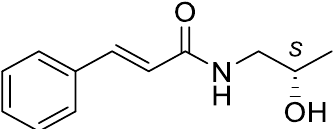
Figure 2. The structure of the title compound: S (+)-(2 E )- N -(2-hydroxypropyl)-3-phenylprop-2- enamide, KM-568.